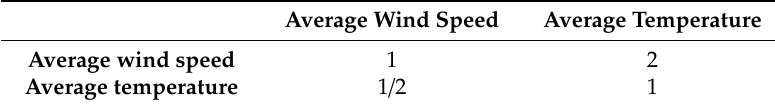
Table 8. Comparison matrix of climatic factors.